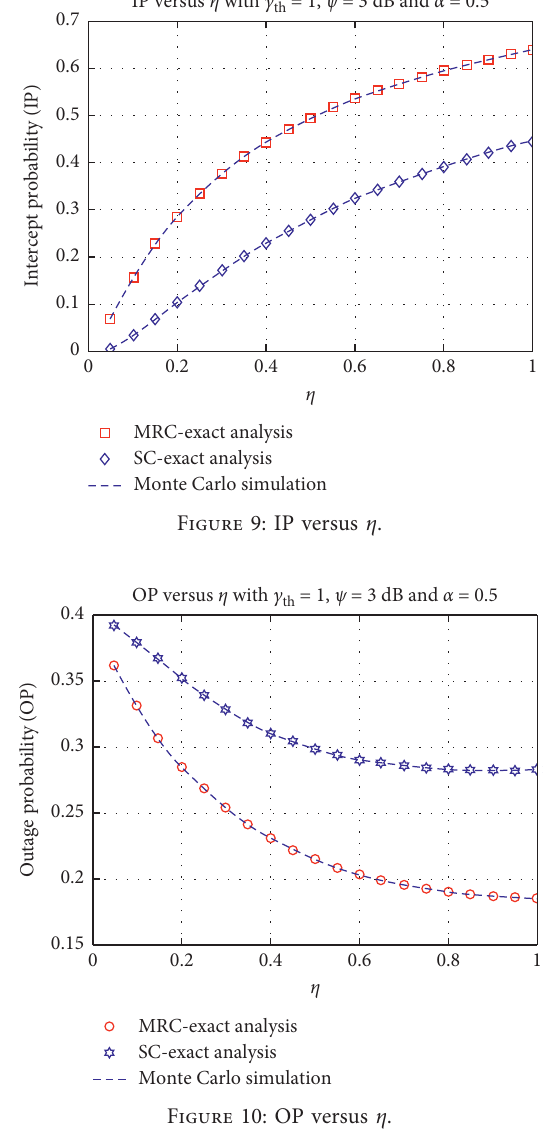
Figure 10: OP versus η